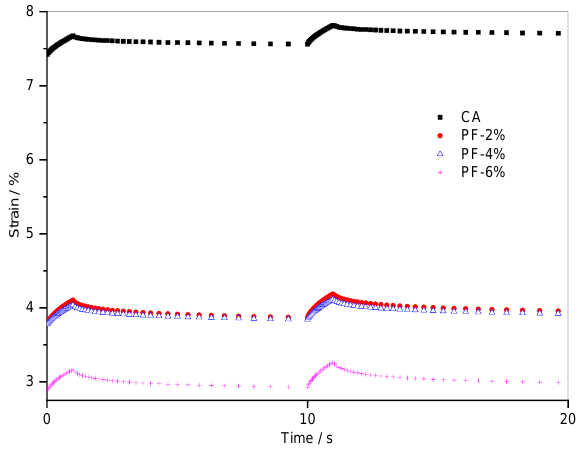
Figure 4. Evolution of strain versus time for composites with polyester fiber in the 50th and 51st cycles. Table 4. Creep deformation and CRR of polyester fiber-reinforced CA in the 50th and 51st cycles.